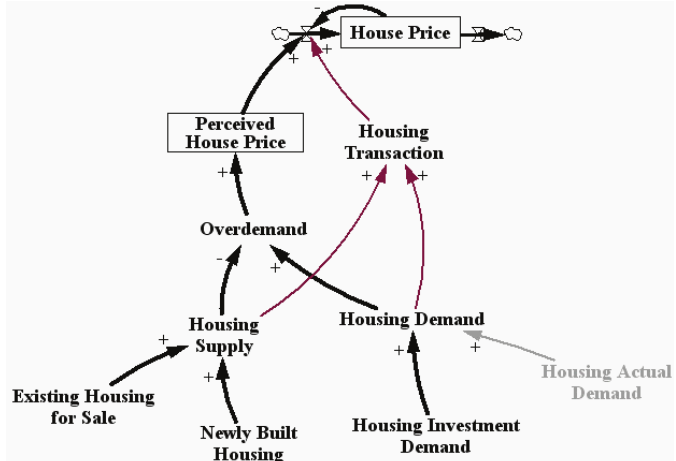
figure 2. House price